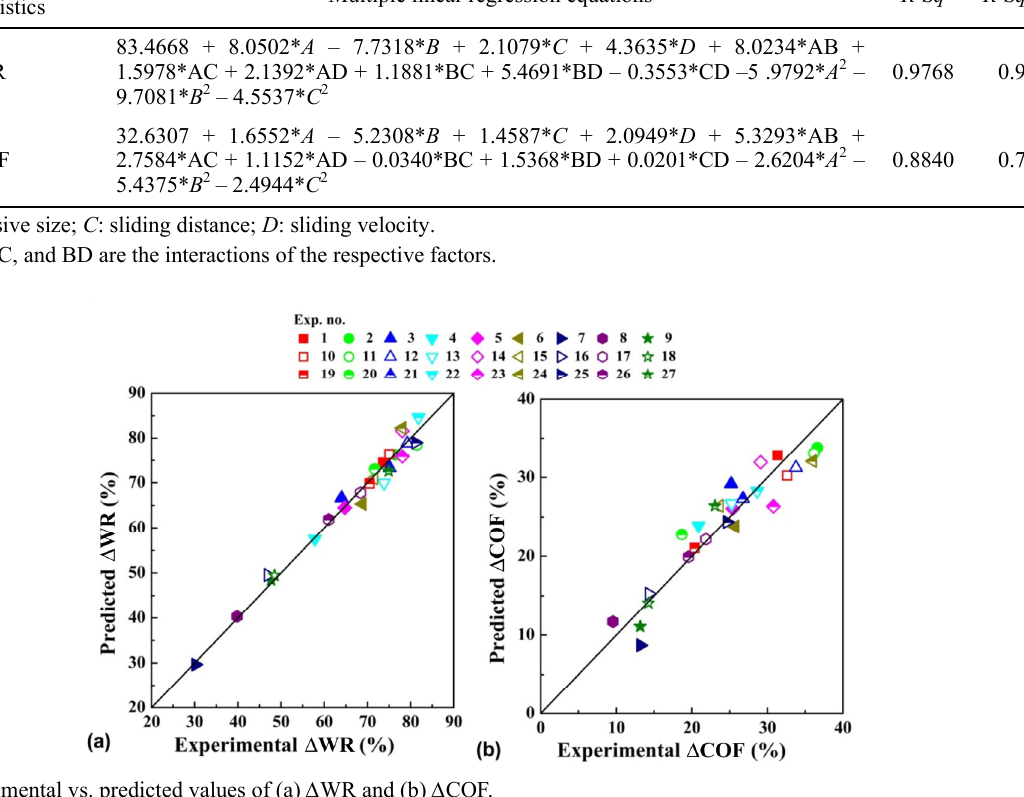
Multiple linear regression equations